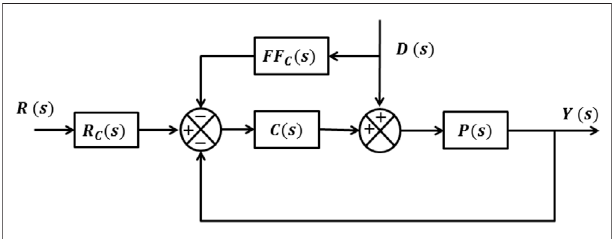
FIGURE 4 | 3DOF-PID controller closed loop expression (Elsisi, 2020).